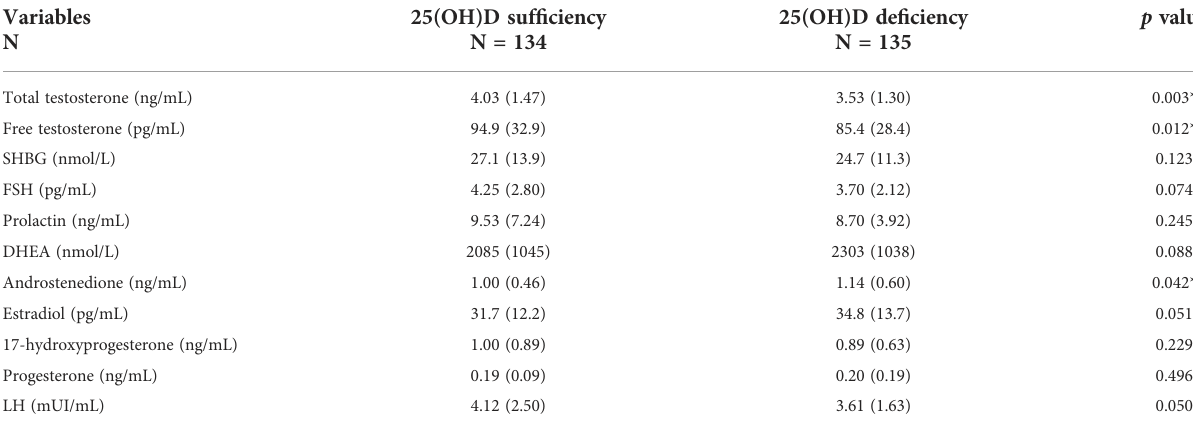
TABLE 2 Summary descriptive table of sex-related hormone pro fi le in the population study, divided by the 50 th percentile of serum 25- hydroxyvitamin D. Variables